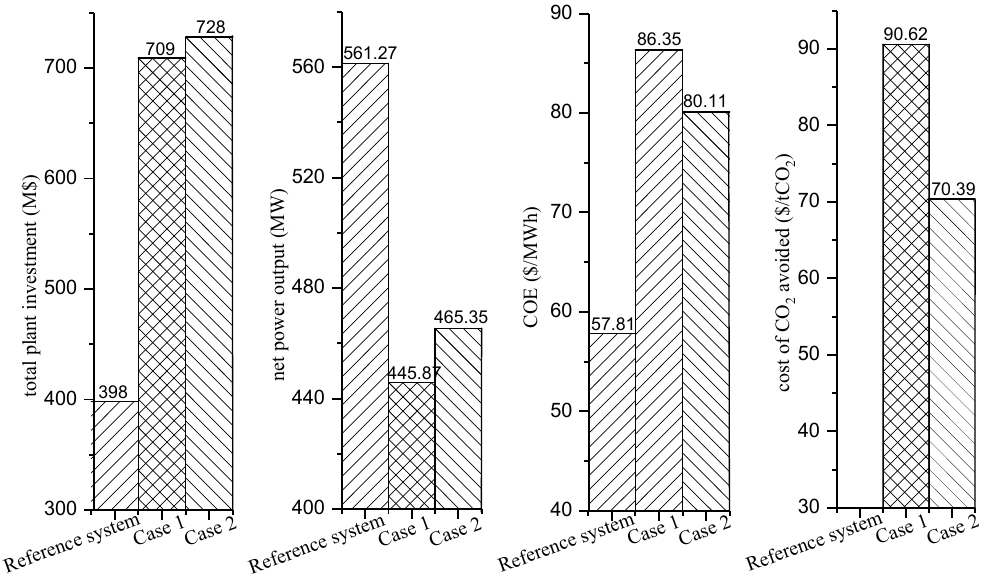
Figure 5. Techno-economic performance graph.